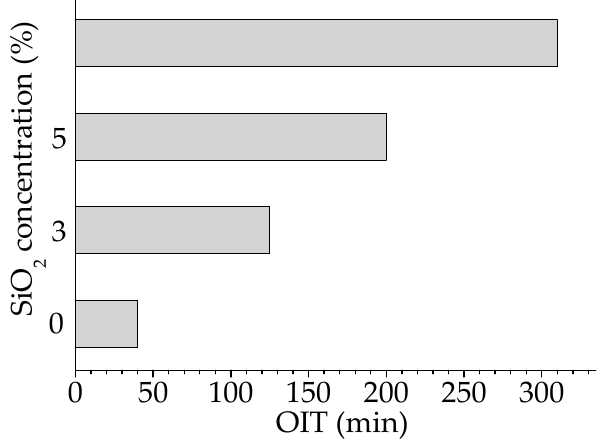
Figure 12. The oxidation induction times of the oxidation of PLA/SIS 30/SiO 2 hybrids obtained by the isothermal CL measurements at 140 °C.